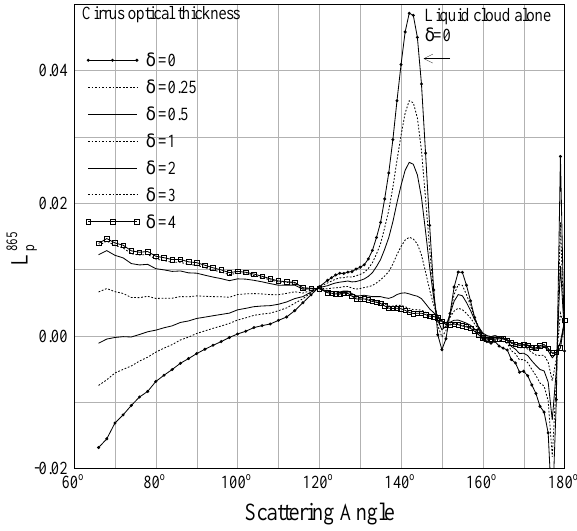
Fig. 6. Simulation of polarized reflectance at 865nm as a func- tion of scattering angle for an ice cloud of varying optical thickness overlaying a lower liquid water cloud of optical thickness